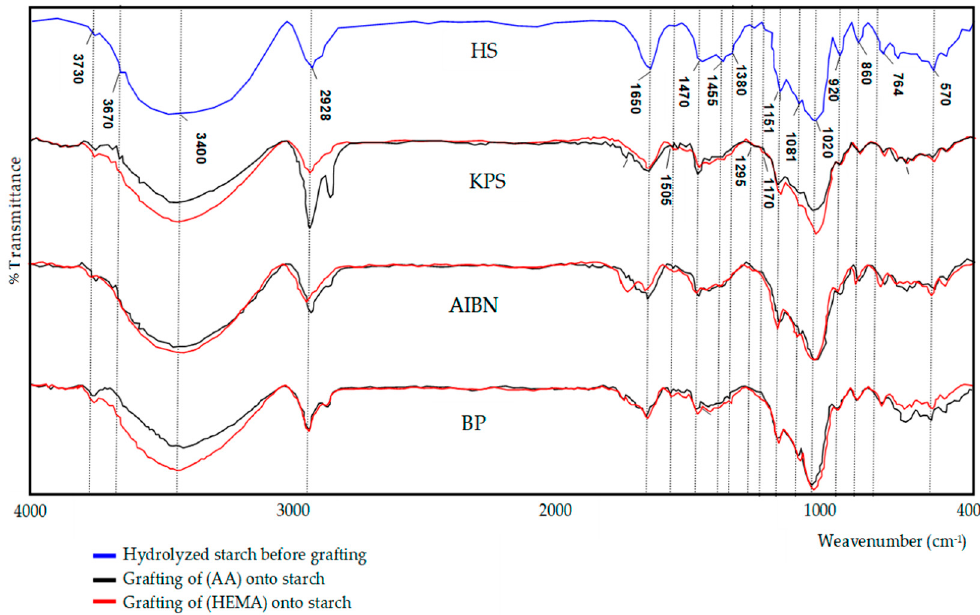
Figure 3. FTIR spectra of the hydrolysed and grafted starch per individual